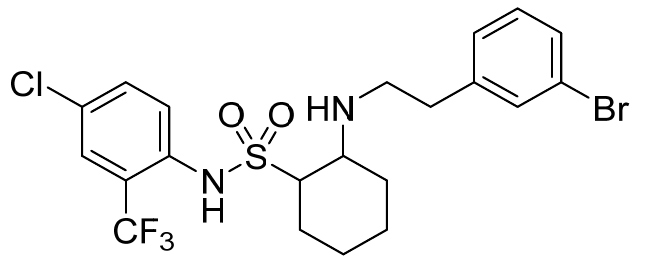
Figure 1. Structure of SYAUP-CN-26 (1 S , 2 R -((3-bromophenethyl) amino)- N -(4-chloro-2-(trifluoro- methyl) phenyl) cyclohexane-1-sulfonamide). omethyl) phenyl)